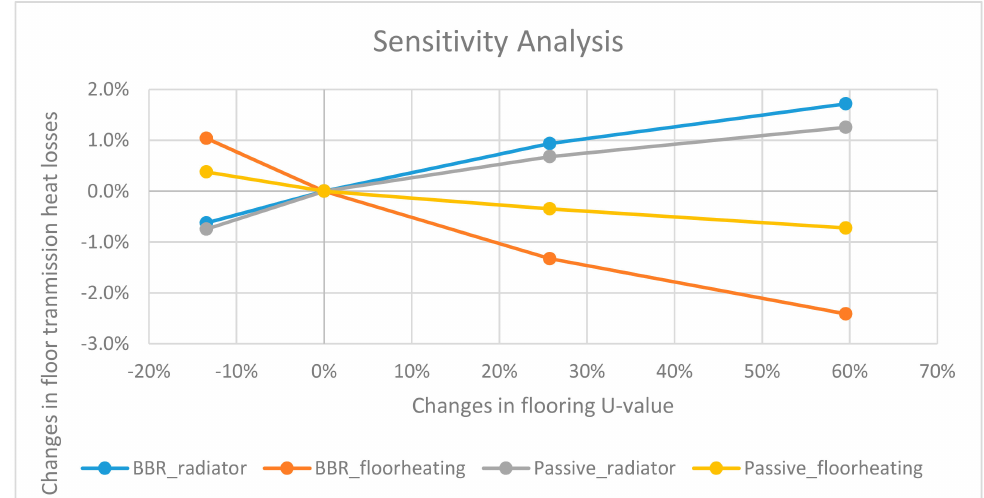
Figure 16. Changes in supply heating demand for space heating versus changes in the total floor U -value in all studied reference